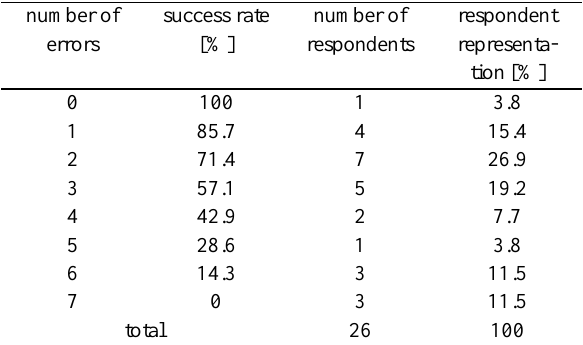
Fig. 5 Faultiness overview in solving the